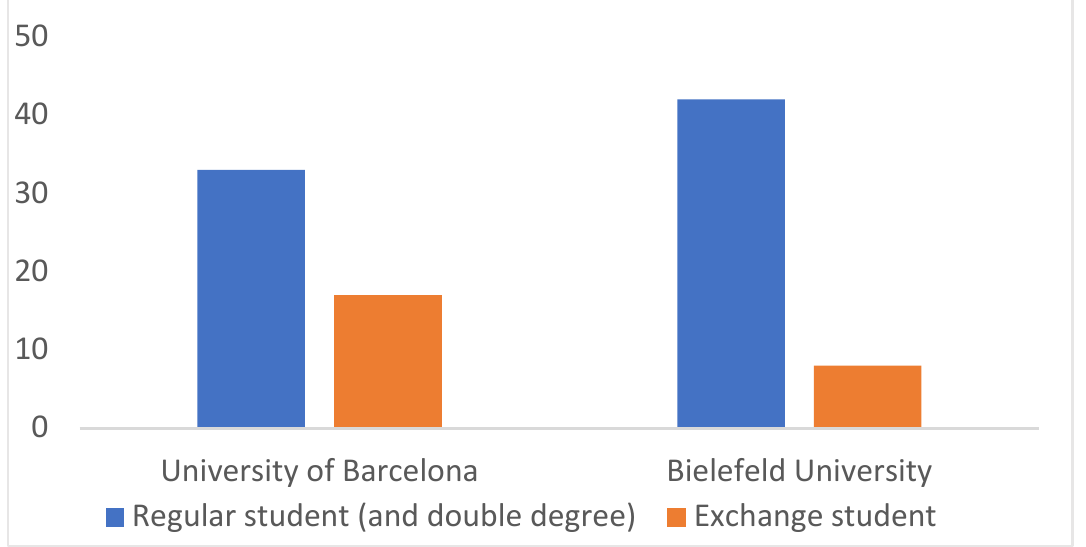
Figure 10. Ratio of regular and exchange students.